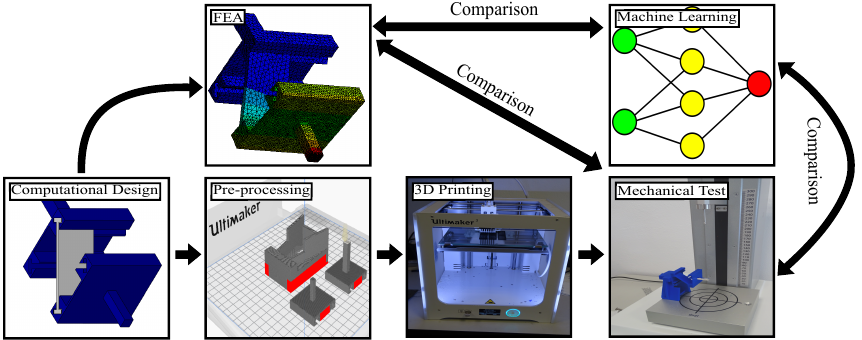
Figure 1. Flowchart with the 6 representative stages of the process used in this work for the compliant cross-axis